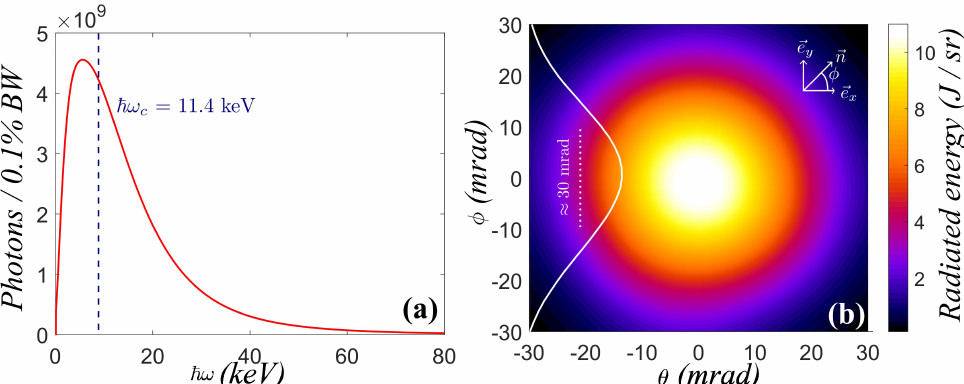
Figure 3. ( a ) The spectral distribution of Betatron photons per 0.1% bandwidth. ( b ) Angular distribu- tion of radiated energy of the Betatron